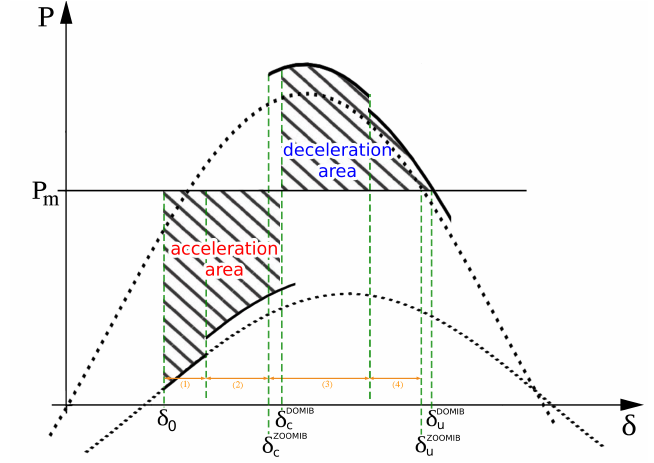
Figure 8. Schematic representation of DOMIB with two added update points (two during-fault intervals and two post-fault intervals). Dashed lines show the initial ZOOMIB (or COOMIB) δ − P curves and solid lines show the updated DOMIB curves.